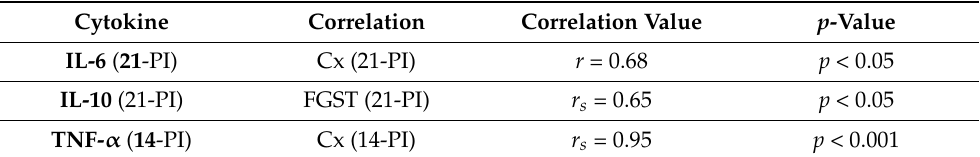
Table 4. Correlative analyses between cytokines and other parametrized variables across infected mice.